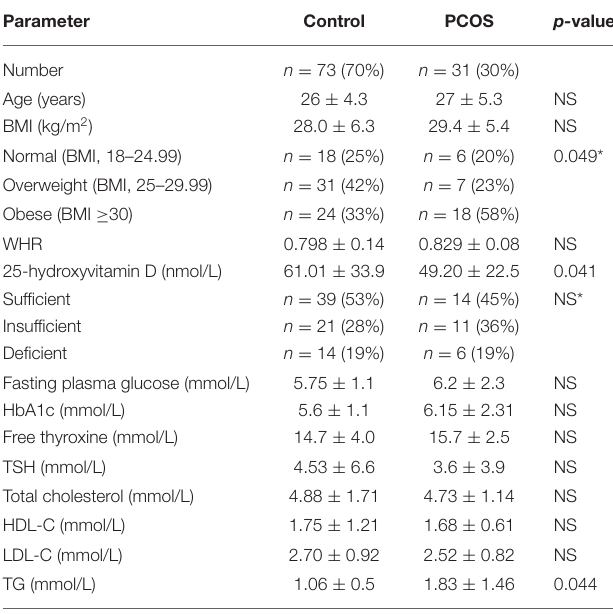
TABLE 1 | Clinical and biochemical features of women with PCOS and controls.